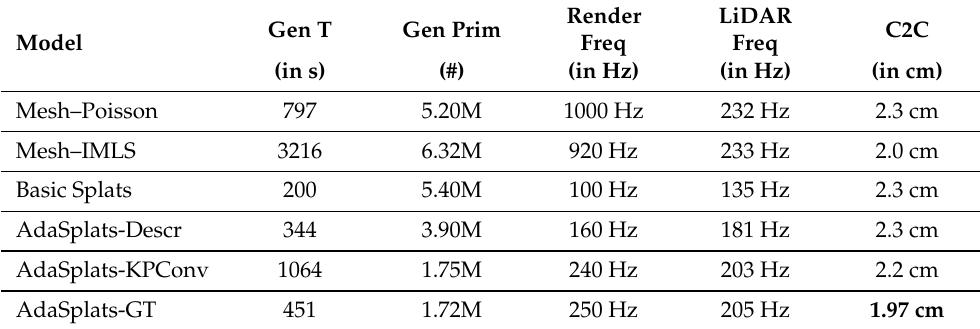
Table 1. Results on PC3D-Paris. We report the time taken (Gen T) in seconds to generate the primitives (triangular mesh or splats), the number of generated primitives (Gen Prim) in millions (M), rendering frequency in Hz (Render Freq) with a resolution of 2560 × 1440 pixels, LiDAR simulation frequency (LiDAR Freq) of the Velodyne HDL-64, and the cloud-to-cloud (C2C) distance between the simulated and original point clouds.